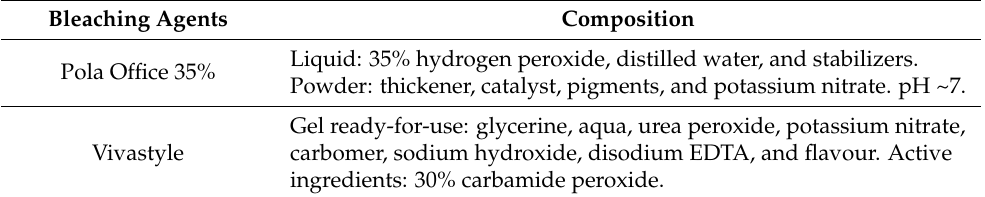
Table 1. Bleaching agent